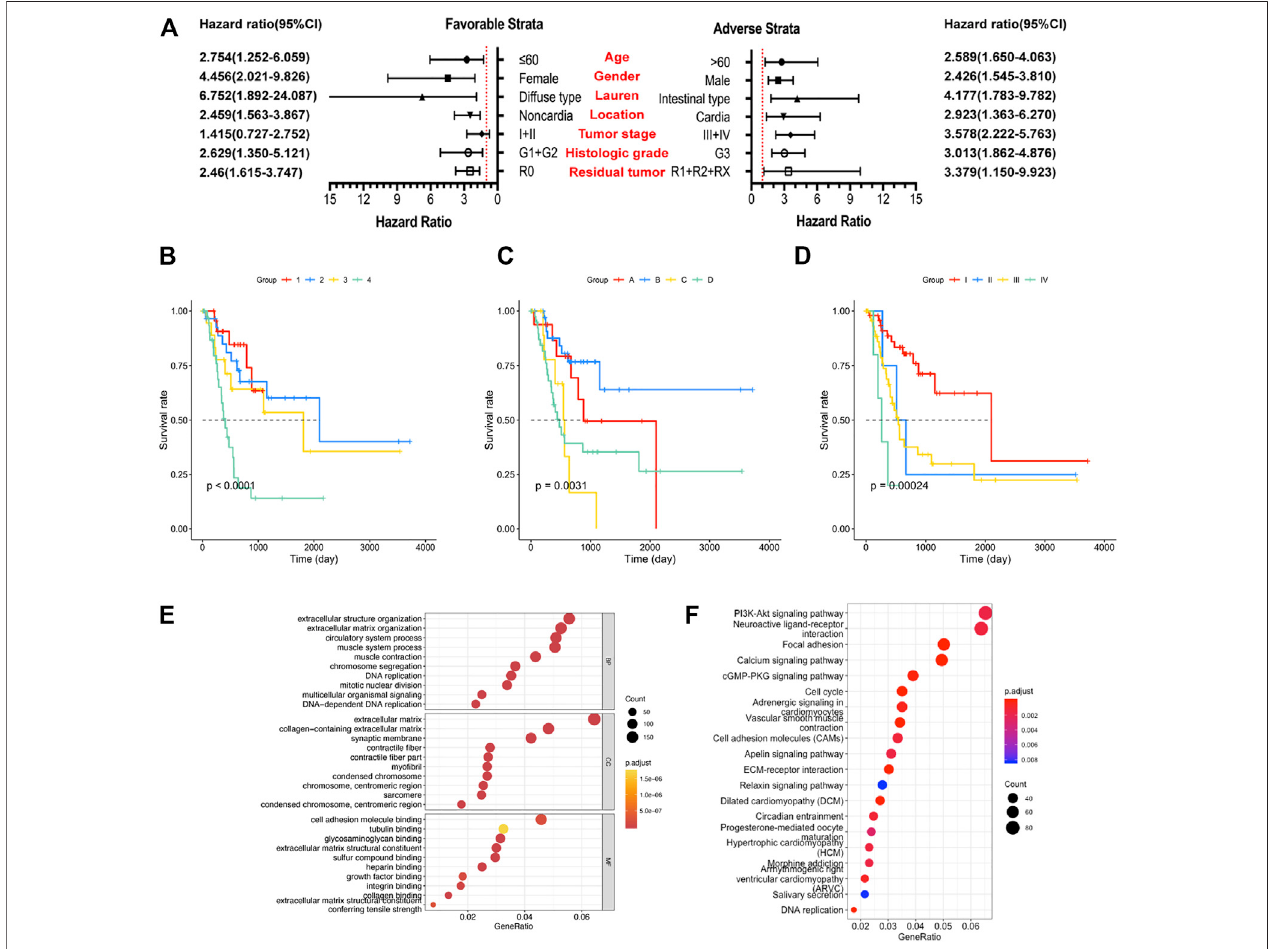
FIGURE 2 | Analysis of the prognostic signature, clinical factors, and enriched pathways. (A) Strati fi ed analysis of risk score and overall survival (OS) of gastric cancer (GC) patients. (B) Joint effect analysis of risk score and tumor stage. (C) Joint effect analysis of risk score and histological grade. (D) Joint effect analysis of risk scoreandresidualtumor. (E) GeneOntologytermanalysisofthebiologicalprocess,cellularcomponents,andmolecularfunctions. (F) ResultsoftheKyotoEncyclopedia of Gene and Genome analysis.